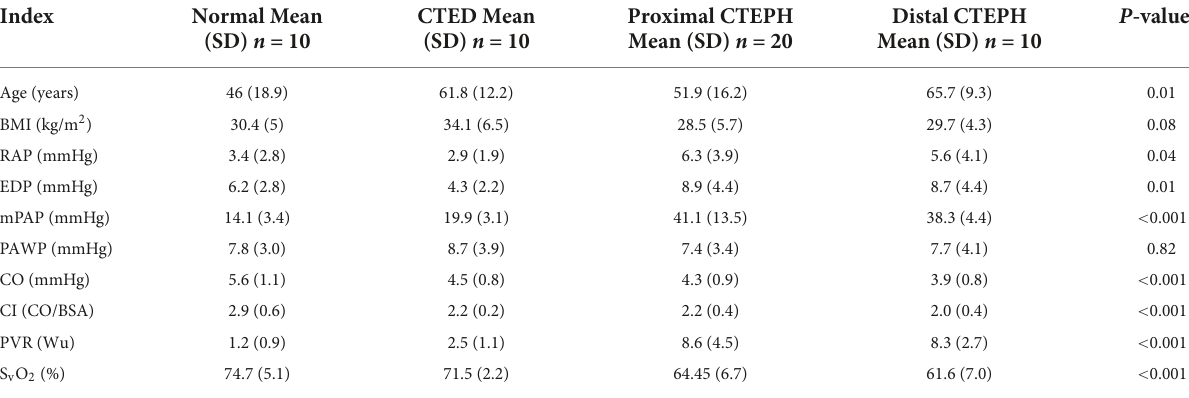
TABLE 6 ANOVA of the hemodynamic values of across all patient